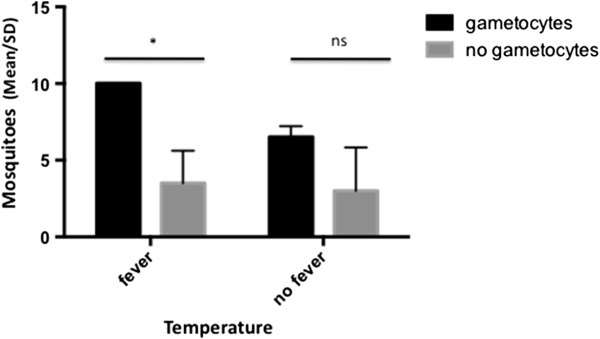
Anopheles darlingi attractiveness to symptomatic vivax malaria patients related to body temperature and parasite stages. Gametocyte carriers were defined as patients with detectable sexual stages of the parasite in blood smears using microscopy. Fever = Individuals with body temperature >37.5°C; No Fever = individuals with body temperature <37.5°C. Two-way ANOVA (fever and gametocytes) and Sidak’s test (comparisons). * indicates significant differences (P < 0.05). NS indicates non-significant differences (P > 0.05). N = 2 for each variable combination (i.e., fever and gametocytes, fever and no gametocytes, no fever and gametocytes and no fever and no gametocytes).